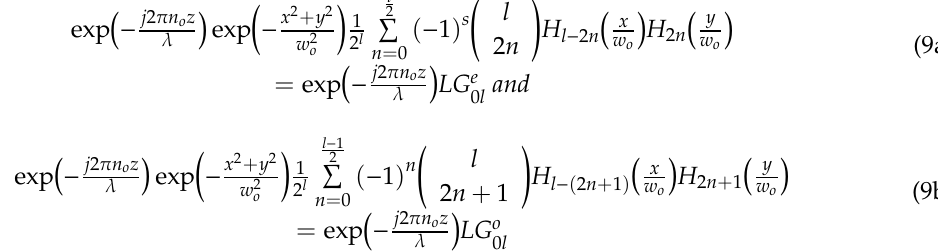
and LG o according to 0 i 0 i